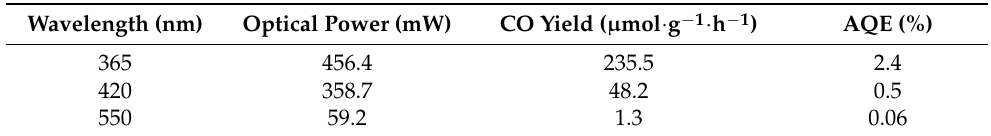
Table 2. Optical power, CO yield, and AQE of the N-NiO-2 at different wavelengths under 2 h of illumination.